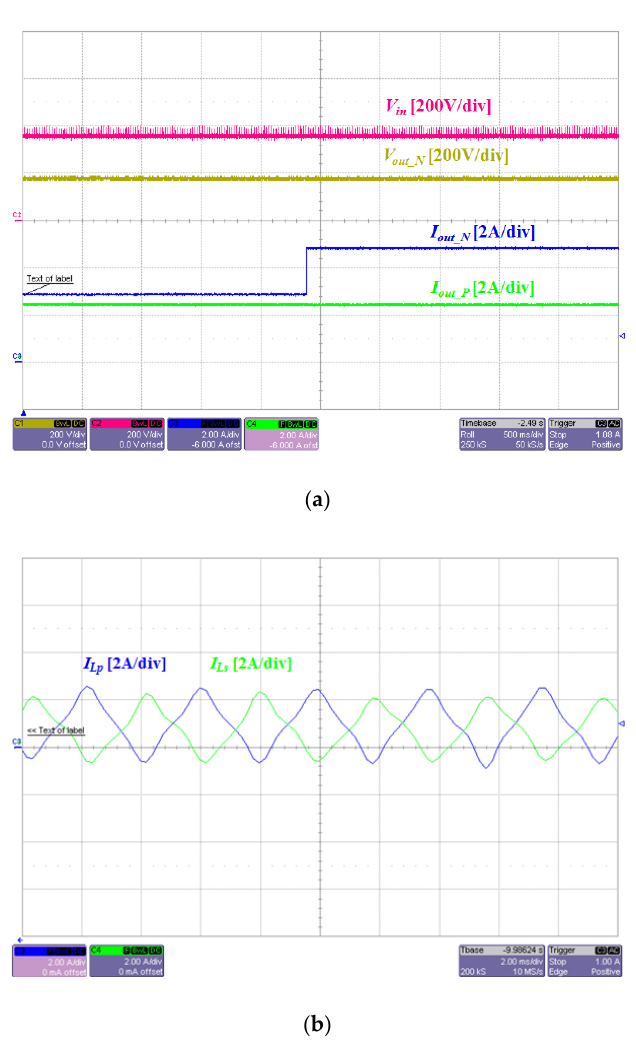
Figure 12. Experimental waveforms under unbalanced load condition: ( a ) Input voltage, negative pole voltage, and load currents; ( b ) inductor currents of each winding.